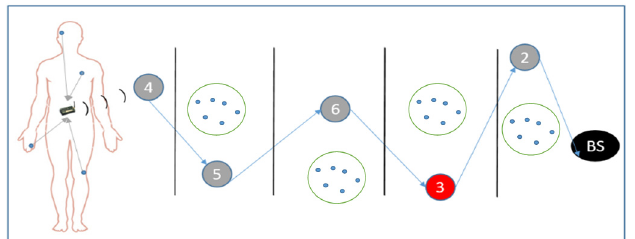
Figure 3. Network model.